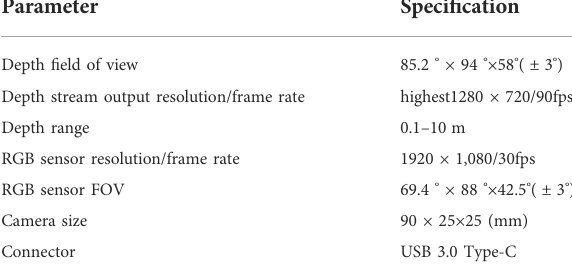
TABLE 1 Camera function parameter